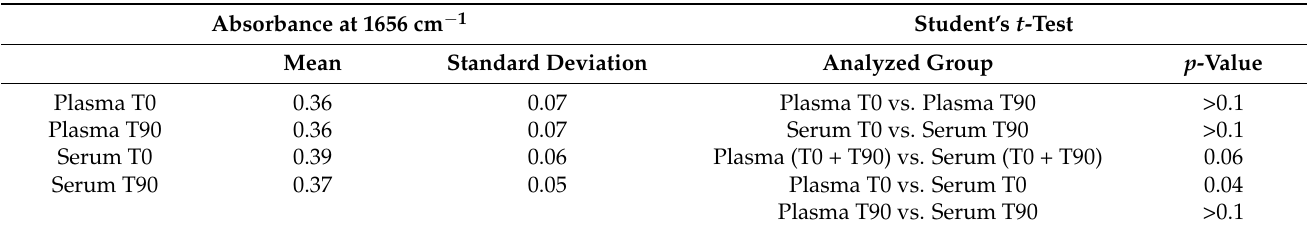
Table 1. Absorbance at 1656 cm − 1 (amide I). The mean value and standard deviation are presented. The p-value of a Student’s t -test analysis is also present.